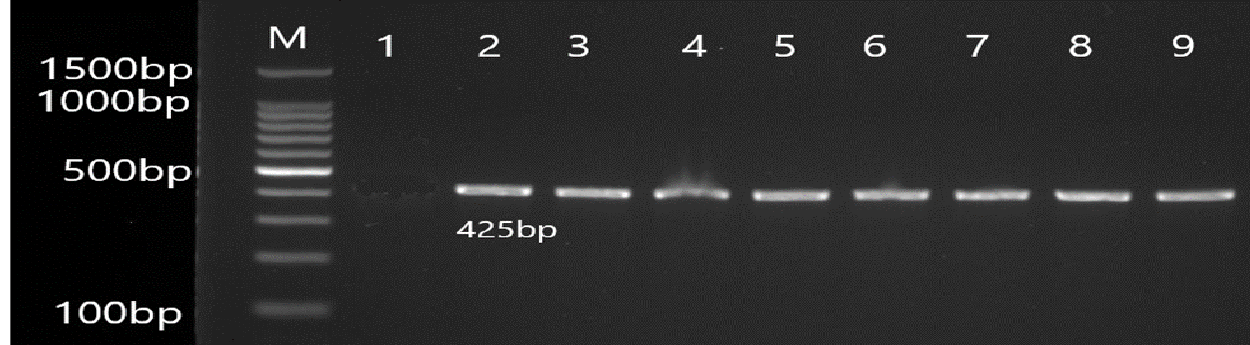
Figure 4. Electrophoresis showing amplicons of P. aeruginosa mexC gene. Lane M: 100 bp molecular marker, Lane 1: Negative control, Lane 2 – 9: Positive isolates of mexC gene .